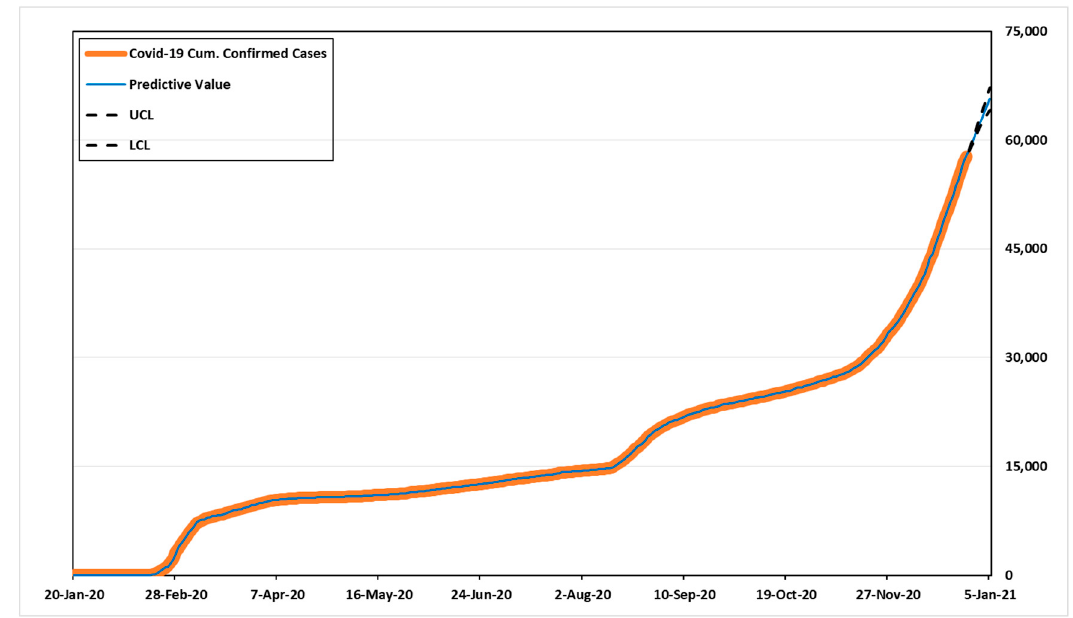
Figure 4. Time ‐ series plot for the best ARIMA (1,2,5). Figure 4. Time-series plot for the best ARIMA